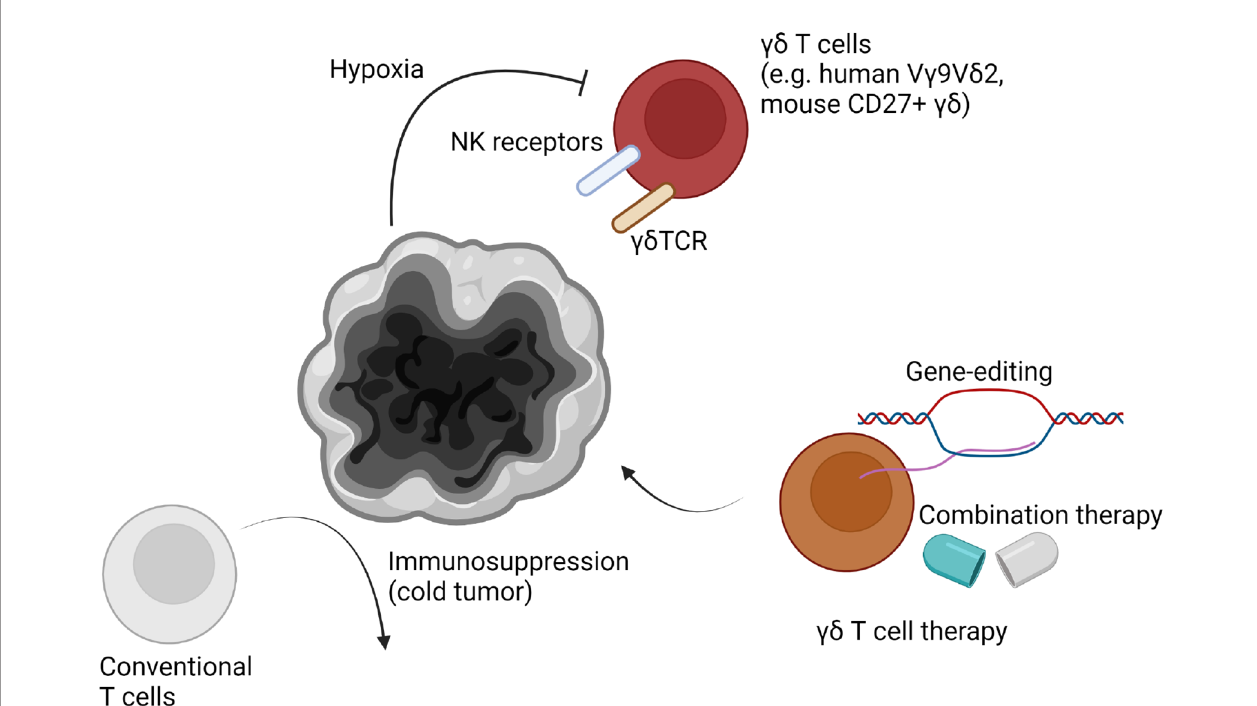
FIGURE 3 | gd T cells in the brain tumor microenvironment. High-grade brain tumors such as glioblastoma multiforme (GBM) are known to be immunosuppressive “ cold tumors ” . Due to strong immunosuppression mechanisms, conventional T cells are malfunctional. However, gd T cells are known to be potent strong anti-brain tumor immune cells. Human V g 9V d 2 T cells or murine CD27+ gd T cells are known to in fi ltrate the tumor microenvironment. They may fi ght with tumor cells through both of gd TCR and NK receptors, including NKG2D. However, gd T cell reactivity is suppressed in the brain tumor microenvironment via severe hypoxia. Additionally, other mechanisms such as chemotherapy-induced cell death can be involved in suppression of gd T cell reactivity. Thus, gene-editing to generate resistant gd T cells or developing combination therapies can enhance gd T cell immunity in the brain tumor